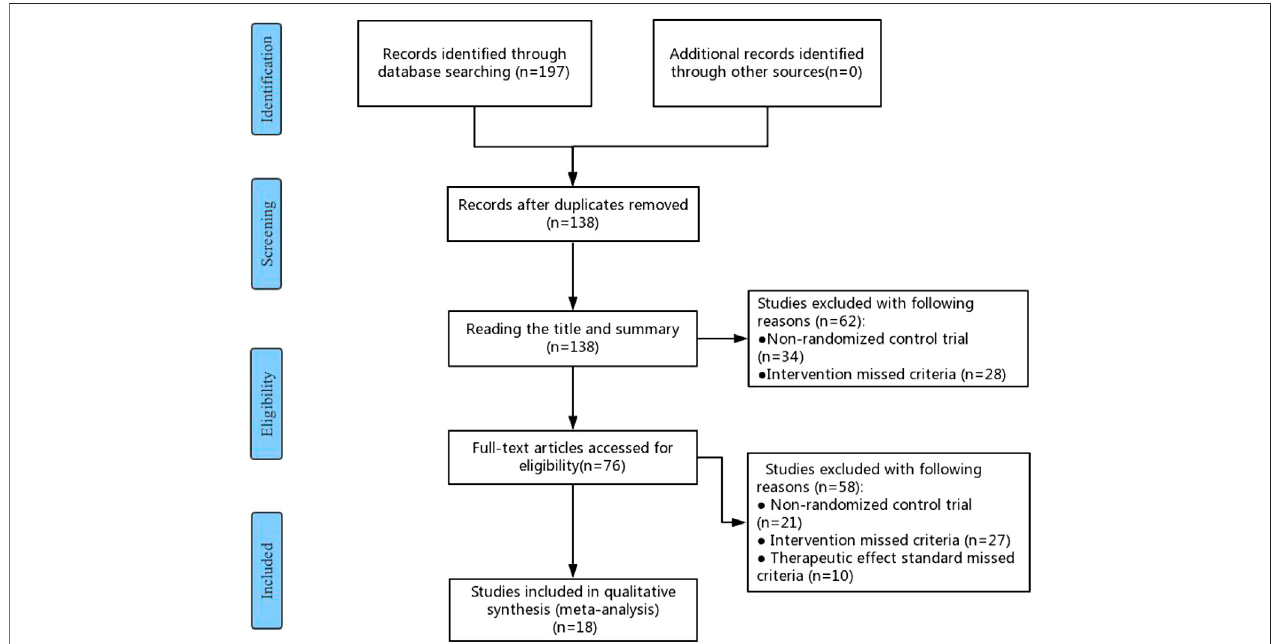
FIGURE 1 | Flow chart of the search for eligible